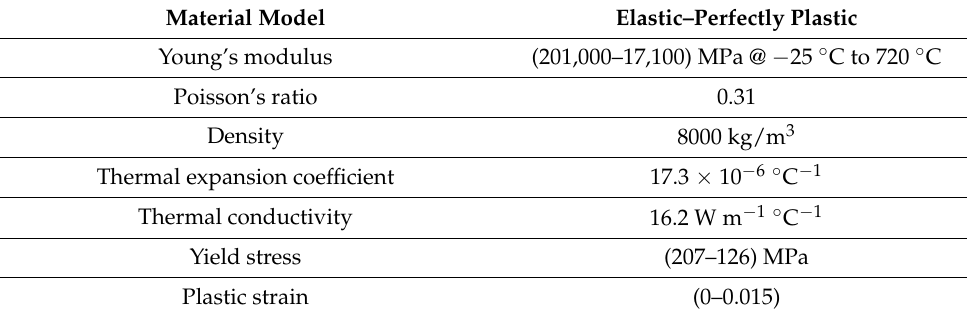
Table 2. Material and physical properties of SS-304 material